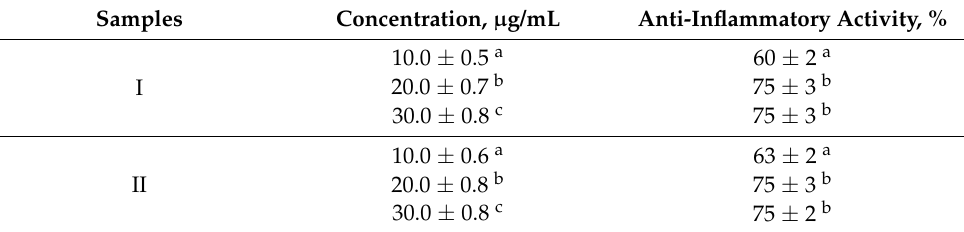
Table 4. The results of determining anti-inflammatory activity of Symphytum officinale extract samples. Samples